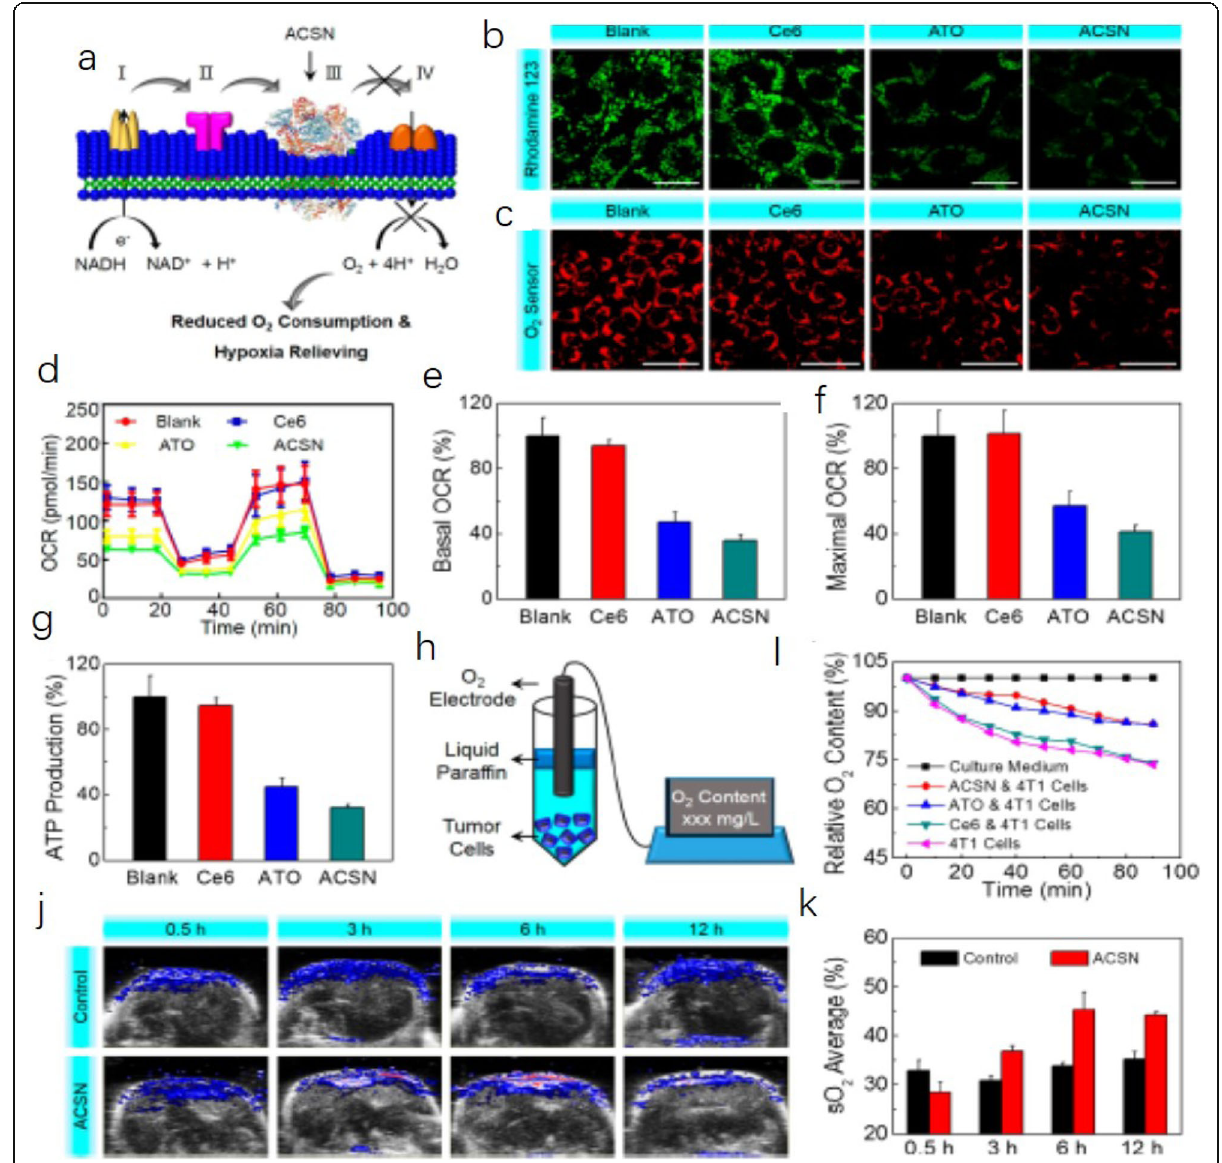
Fig. 9 ACSN was injected i.v. to detect 4 T1 tumor-bearing mice by PAI